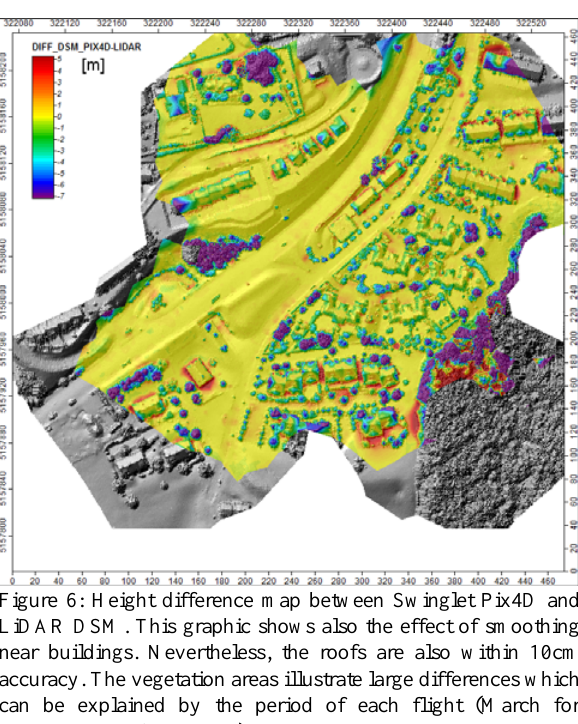
Figure 6: Height difference map between Swinglet Pix4D and LiDAR DSM. This graphic shows also the effect of smoothing near buildings. Nevertheless, the roofs are also within 10cm accuracy. The vegetation areas illustrate large differences which can be explained by the period of each flight (March for Swinglet, June for